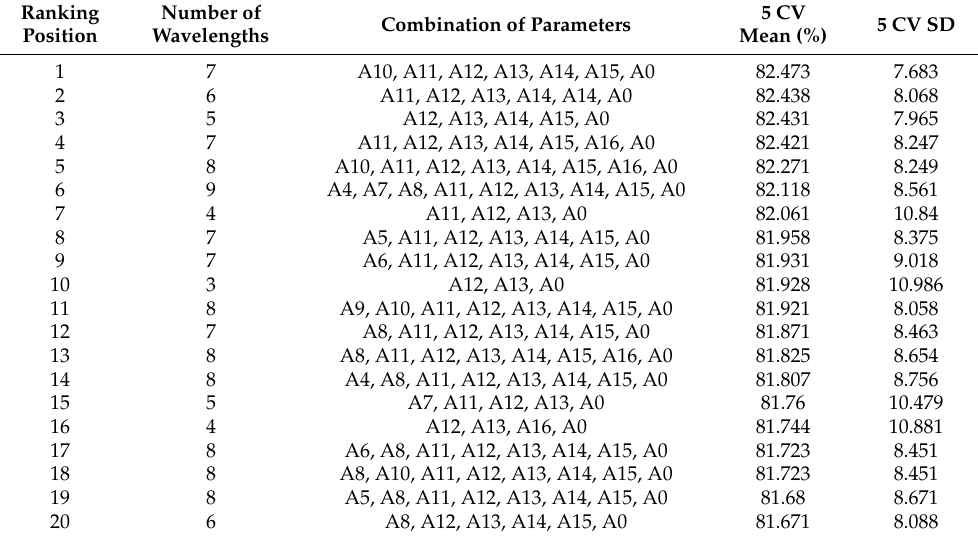
Table 3. Top 20 ranking for multiple wavelength usage for white eggshells, without hyperparameter